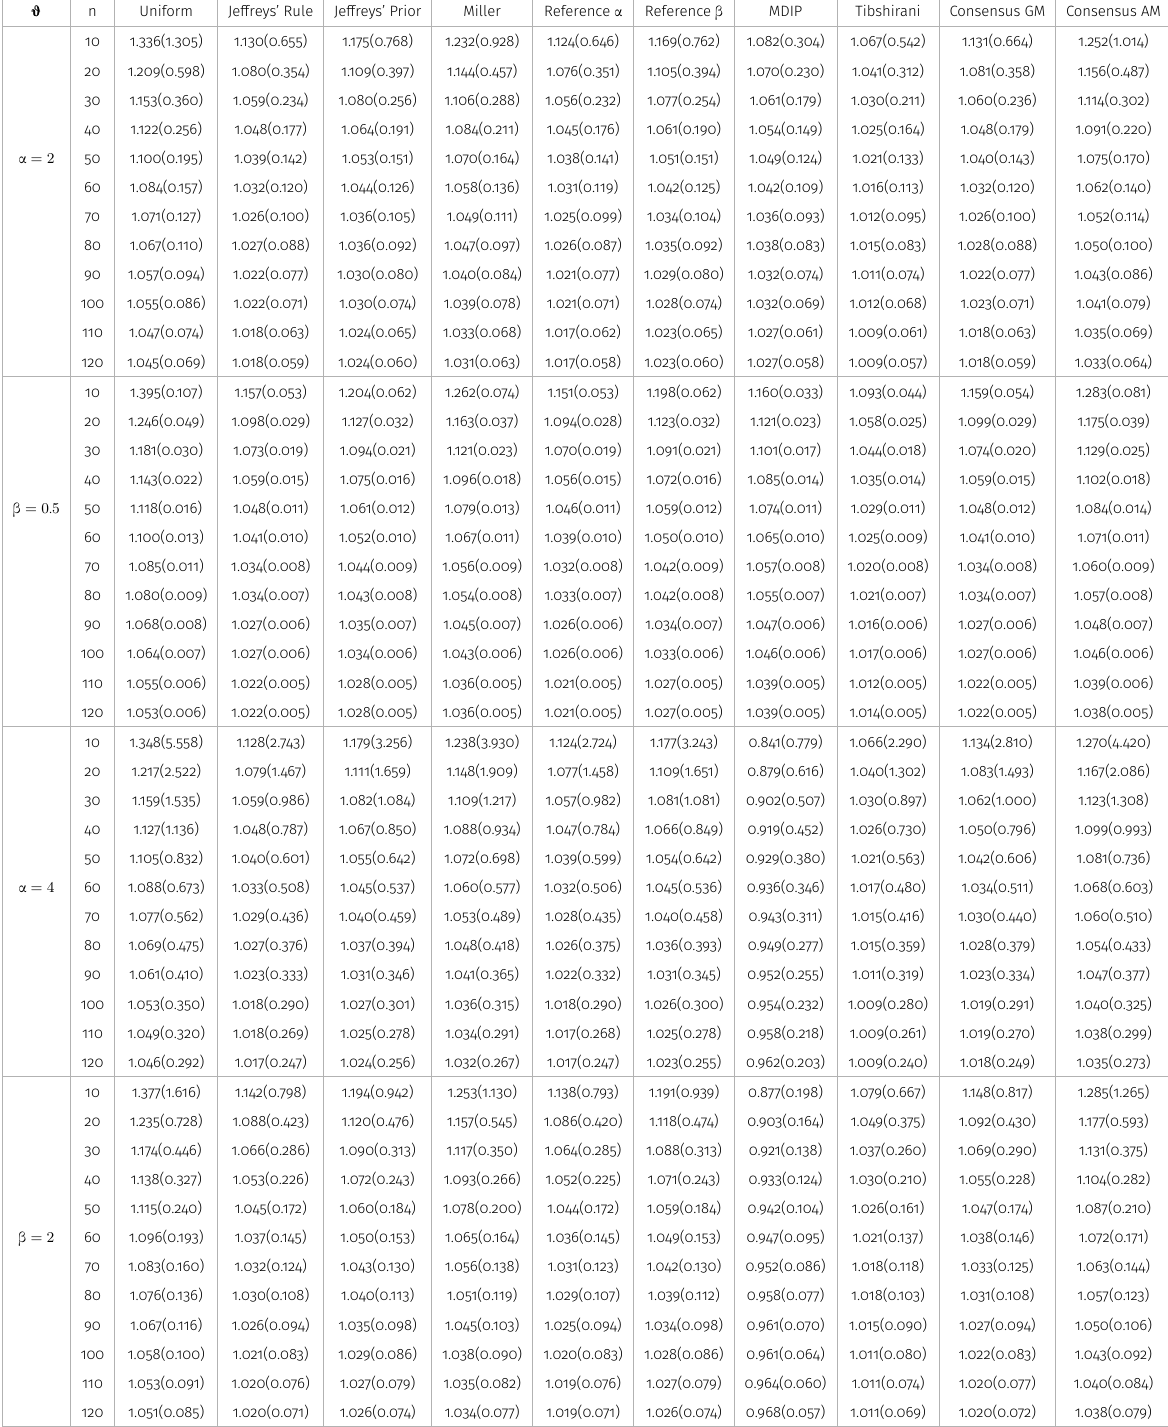
Table II. The MRE(MSE) for for the estimates of α and β considering different sample